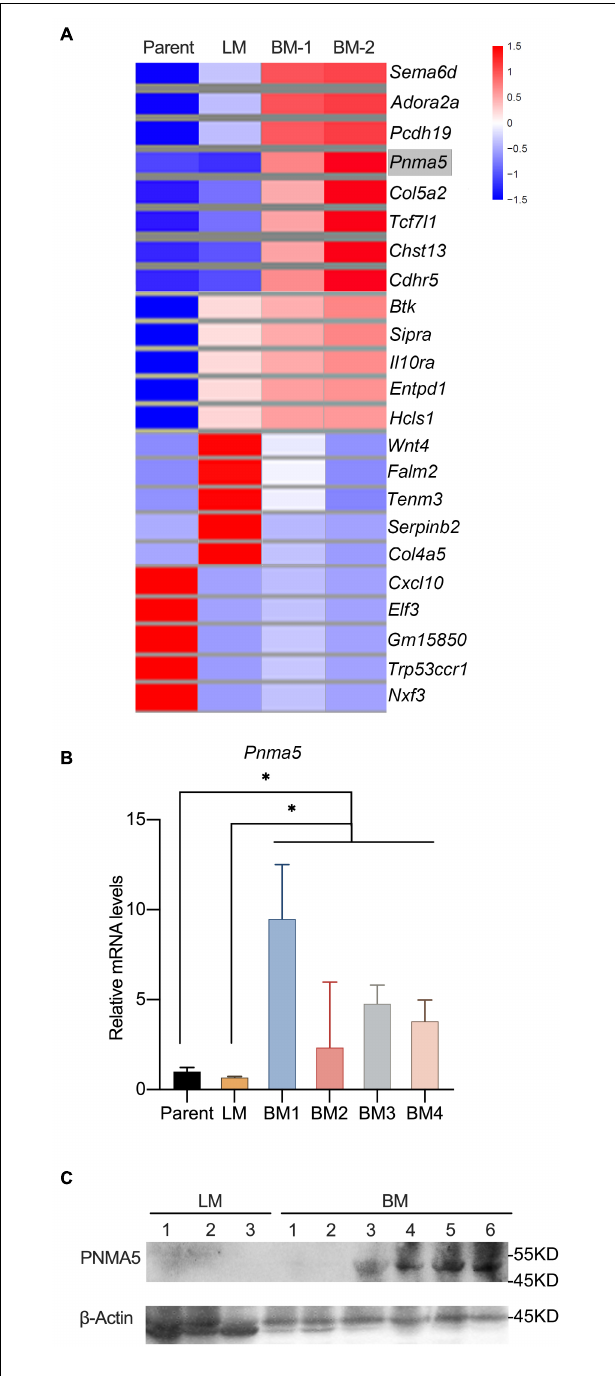
FIGURE 1 | Pnma5 is highly expressed in bone metastasis of Lewis lung carcinoma. (A) Heatmap with mRNA-based expression of representative genes in bone metastasis (BM-1 and BM-2), lung metastasis (LM) and parental Lewis lung cells (Parent). The gene names were shown on the right of the heatmap. Values are normalized intensities, log2. (B) Comparison of relative Pnma5 mRNA levels of bone metastasis (BM), lung metastasis (LM) and parental Lewis lung cells (Parent) by qPCR. * P < 0.05. (C) Lysates of the indicated tissues were harvested to be subjected to western blot for PNMA5. β -Actin was the reference for the blots. LM, lung metastasis; BM, bone metastasis.